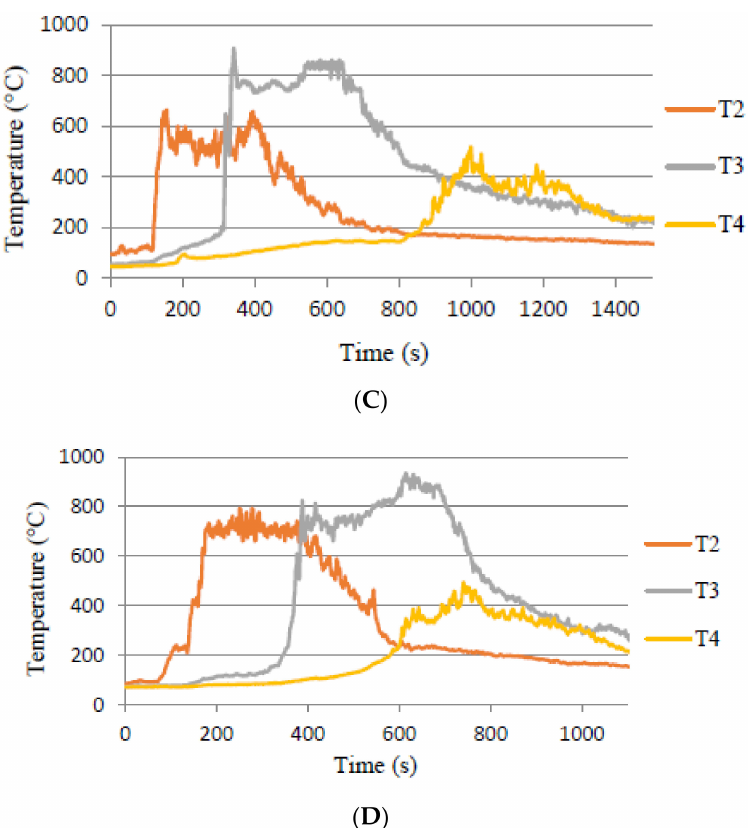
Figure 3. Temperature variation versus time for: ( A ) Type 1 briquettes (corrugated cardboard); ( B ) Type 2 briquettes (office paper); ( C ) Type 3 briquettes (mixture of paper waste); ( D ) Type 4 briquettes (mixture of paper and green